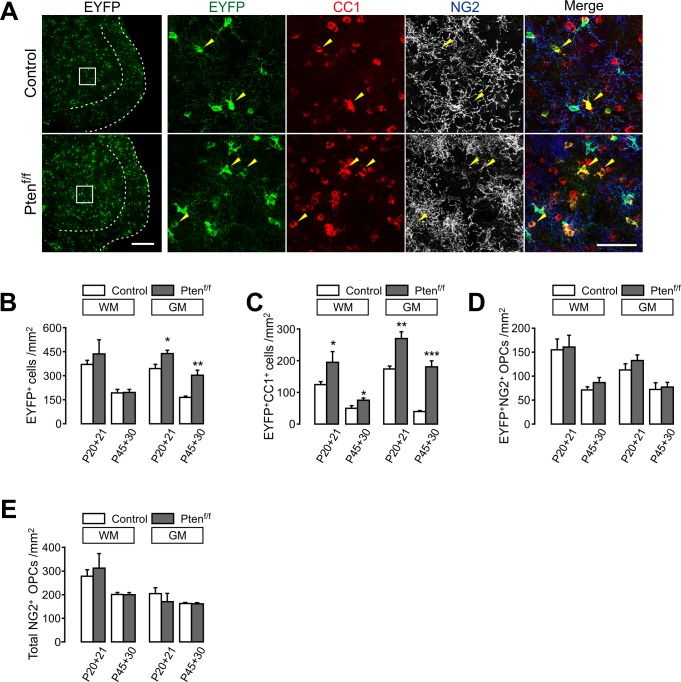
OPC-specific Pten ablation enhances oligodendrocyte differentiation in the spinal cord.(A) Fluorescence (left) and confocal (right) images of SC EYFP+ cells in Pdgfra-CreER; R26-EYFP; ±Ptenf/f mice (P20 +21). The identity of EYFP+ cells in the boxed areas (left) was determined by co-immunostaining with maturation stage markers (right). Arrowheads indicate newly generated EYFP+CC1+ OLs. Scale bars, 100 µm (left) and 50 µm (right). (B - E) Quantification of EYFP+ cells (B), EYFP+CC1+ new OLs (C), EYFP+NG2+ OPCs (D) and total NG2+ OPCs (E) in the SC of control and Pten cKO mice. Data are represented as mean ±S.E.M. n = 3 ~ 6 (control), or 3 ~ 5 (Pten cKO) mice. *p<0.05; **p<0.01; ***p<0.001. Unpaired Student's t-test. The numerical data for the graphs are available in Figure 2—figure supplement 1—source data 1.10.7554/eLife.32021.009Figure 2—figure supplement 1—source data 1.Numerical data for graphs in Figure 2—figure supplement 1.